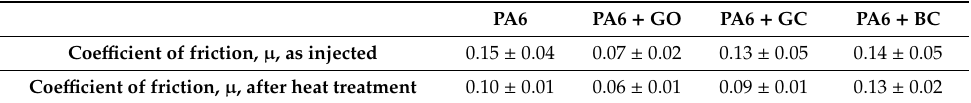
Table 4. Mean value of the coe ffi cient of friction determined for composites and reference